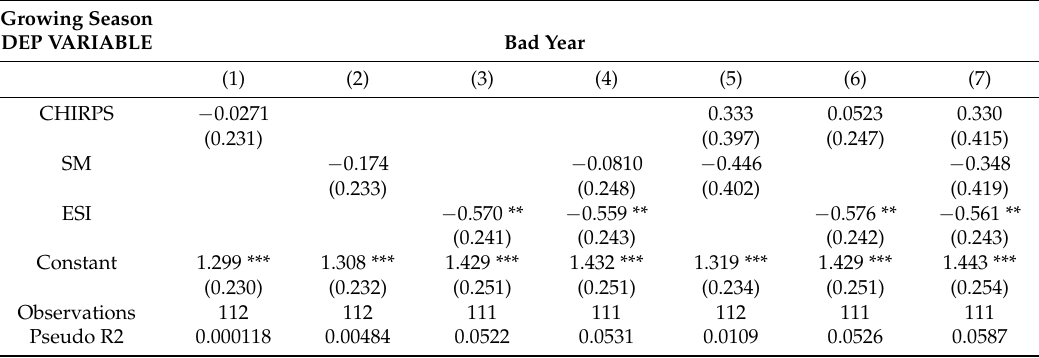
Table 4. Logit regression results focusing on maize-growing months for rainfall (Column 1), soil moisture (Column 2), ESI (Column 3), soil moisture and ESI (Column 4), rainfall and soil moisture (Column 5), rainfall and ESI (Column 6), and all variables combined (Column 7); “bad years” are the dependent variable; rows represent the regression coefficient for the three independent variables (rainfall, soil moisture, ESI), the regression constant, the number of observations, the pseudo R-squared, and the number of countries (8); asterisks mark statistically significant